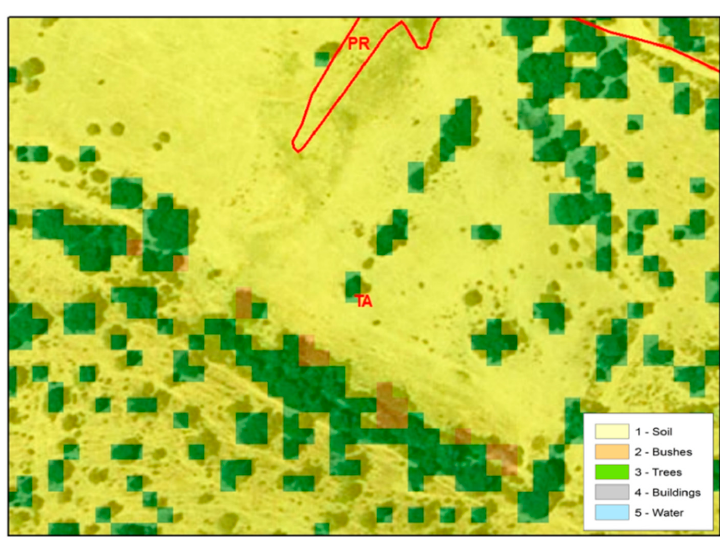
Figure 14. Raster with the final class for each pixel: soil (yellow), bushes (orange) and tree groups (green).